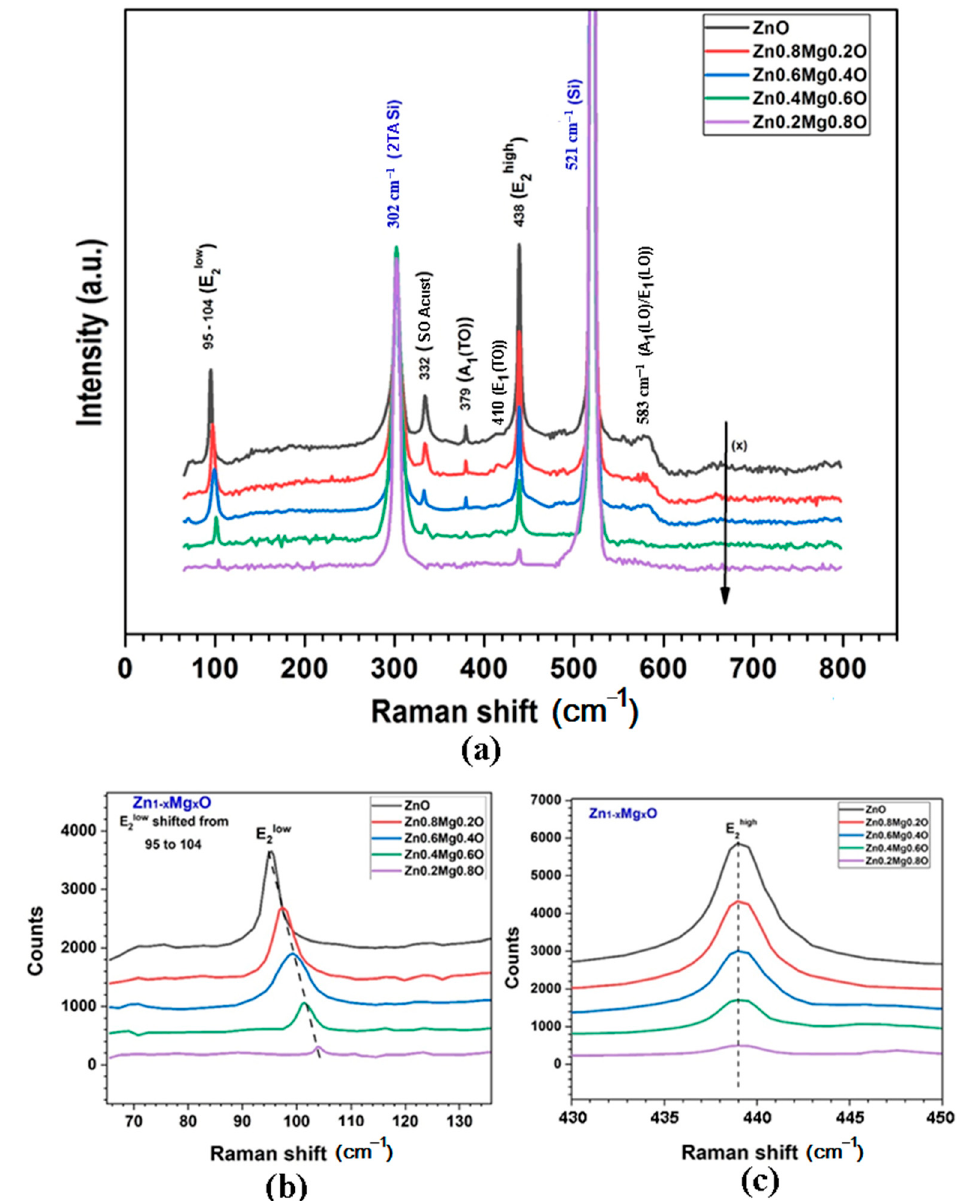
Figure 5. ( a ) RS spectra of Zn 1 − x Mg x O films deposited by spin coating. ( b ) Evolution of the E 2low mode in the wurtzite phase with increase of the x value. ( c ) Evolution of the E 2high mode with increase of the x value.